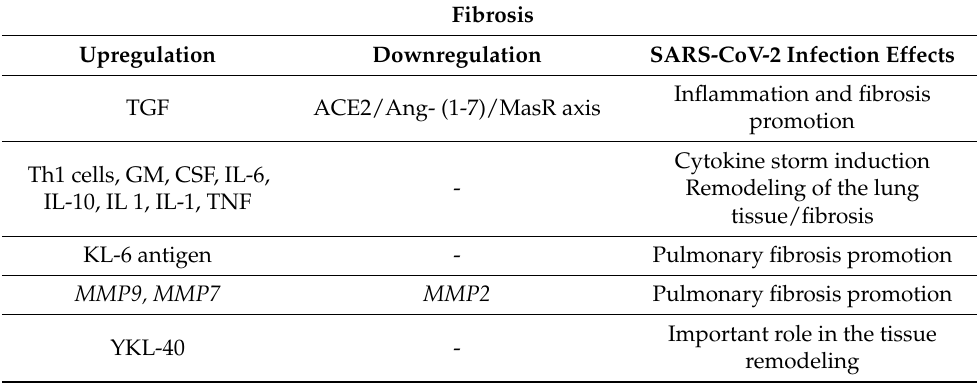
Table 3. Processes in the COVID-19 lungs involved in fibrosis